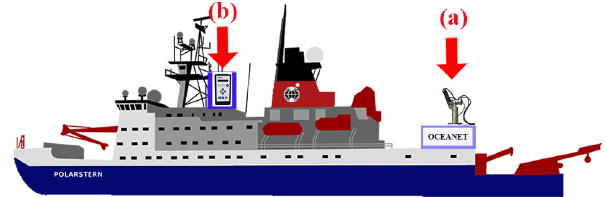
Figure 2. Photometer and lidar observations aboard RV Polarstern . MICROTOPS II observations were performed at site (b) . Lidar and shipborne CE318-T observations were conducted at site (a) .